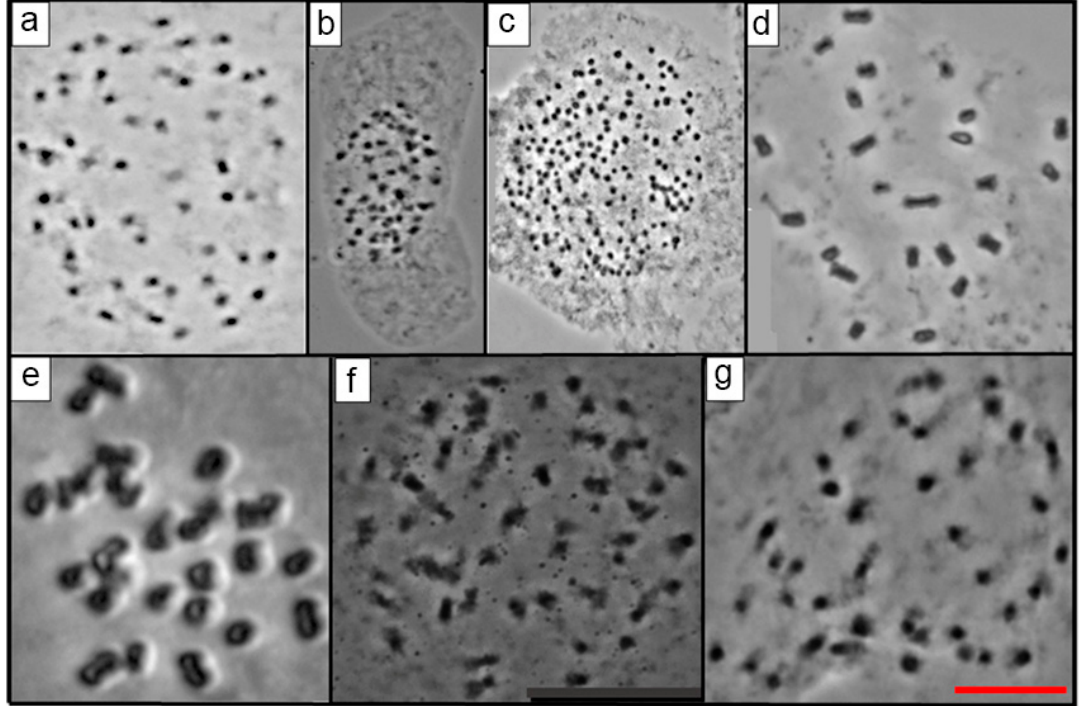
Figure 4. ( a ) E. pallida 2 n = 54, ( b ) E. perezcalixii 2 n = 54, ( c ) E. roseiflora 2 n = 270, ( d ) E. schaffneri 2n = 24, ( e ) E. triquiana 2 n = 32, ( f ) E. Uhlii 2 n = 54 and ( g ) E. zorzaniana 2 n = 40. Scale equals 10 µm. With reference to the different series, from the 23 species of Echeveria studied here, 13 belong to the series Gibbiflorae. Six were diploids: E. guerrerensis , E. juarezensis , E. mag- nifica , E. pallida , and E. perezcalixii , all of them with 2 n = 2 x = 54. E. triquiana had 2 n = 2 x = 32. Three species were tetraploid, including E. altamirae , E. cupreata. and E. dactylifera , where 2 n = 4 x = 108. Meanwhile, E. longiflora was a hexaploid with 2 n = 6 x = 162 and E. roseiflora was a decaploid with 2 n = 10 x = 270. Two species were polyploid–aneuploid: E. gibbiflora with 2 n = 6 x + 10 = 172 and E. novogaliciana with 2 n = 6 x + 14 = 176. The last three species corresponded to the species with the highest chromosome numbers in the series Gibbiflorae (Tables 1 and 2; Figures 1–4). Four species of the 23 analyzed belong to the Racemosae series: Echeveria carnicolor (2 n = 2 x = 36), E. helmutiana (2 n = 2 x = 42), E. olivacea (2 n = 2 x = 28), and E. uhlii (2 n = 2 x = 54); the last value is equal to that observed in several species of the series Gibbiflorae (Ta- bles 1 and 2; Figures 1 and 2). The series Angulatae was represented by two diploid spe- cies: E. schaffneri (2 n = 2 x = 24) , and E. catorce (2 n = 2 x = 24). With two populations analyzed in this research, the chromosome number presented by the last species was the lowest value reported in this study (Tables 1 and 2). The series Pruinosa, Urbinae, Nudae, and Echeveria were represented by a single species in each case, which in that order correspond to E. cuicatecana (2 n = 5 x = 60) and to E. caamanoi (2 n = 5 x = 60), which were pentaploids, to E multicaulis (2 n = 2 x = 32) and E. zorzaniana (2 n = 2 x = 40), both diploids. (Table 2). The differences among the series concerning chromosome numbers were significant among Gibbiflorae, Racemosae, and Angulatae (ANOVA: F 2,18 = 20.28, p < 0.0001). The Tukey–Kramer test comparisons among the series showed that the mean of the chromo- some numbers of the Gibbiflorae series ( x(cid:3364) = 104.3 ± 15.6) was significantly higher than the mean of chromosome numbers of the Racemosae series ( x(cid:3364) = 40 ± 29.2). Similarly, the mean